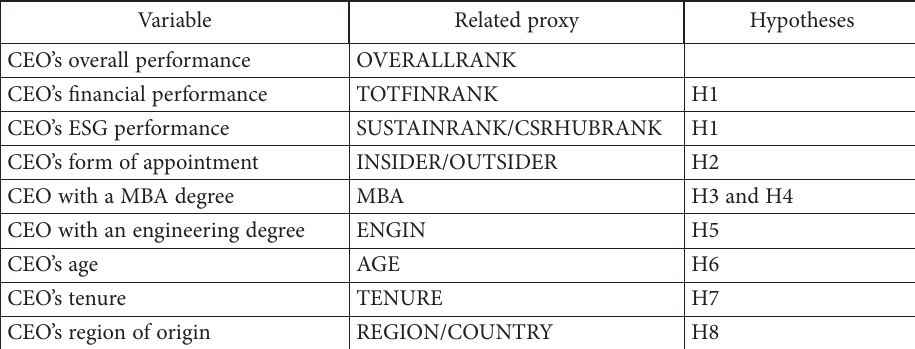
Table 2. Variables, related proxies and relationship with the